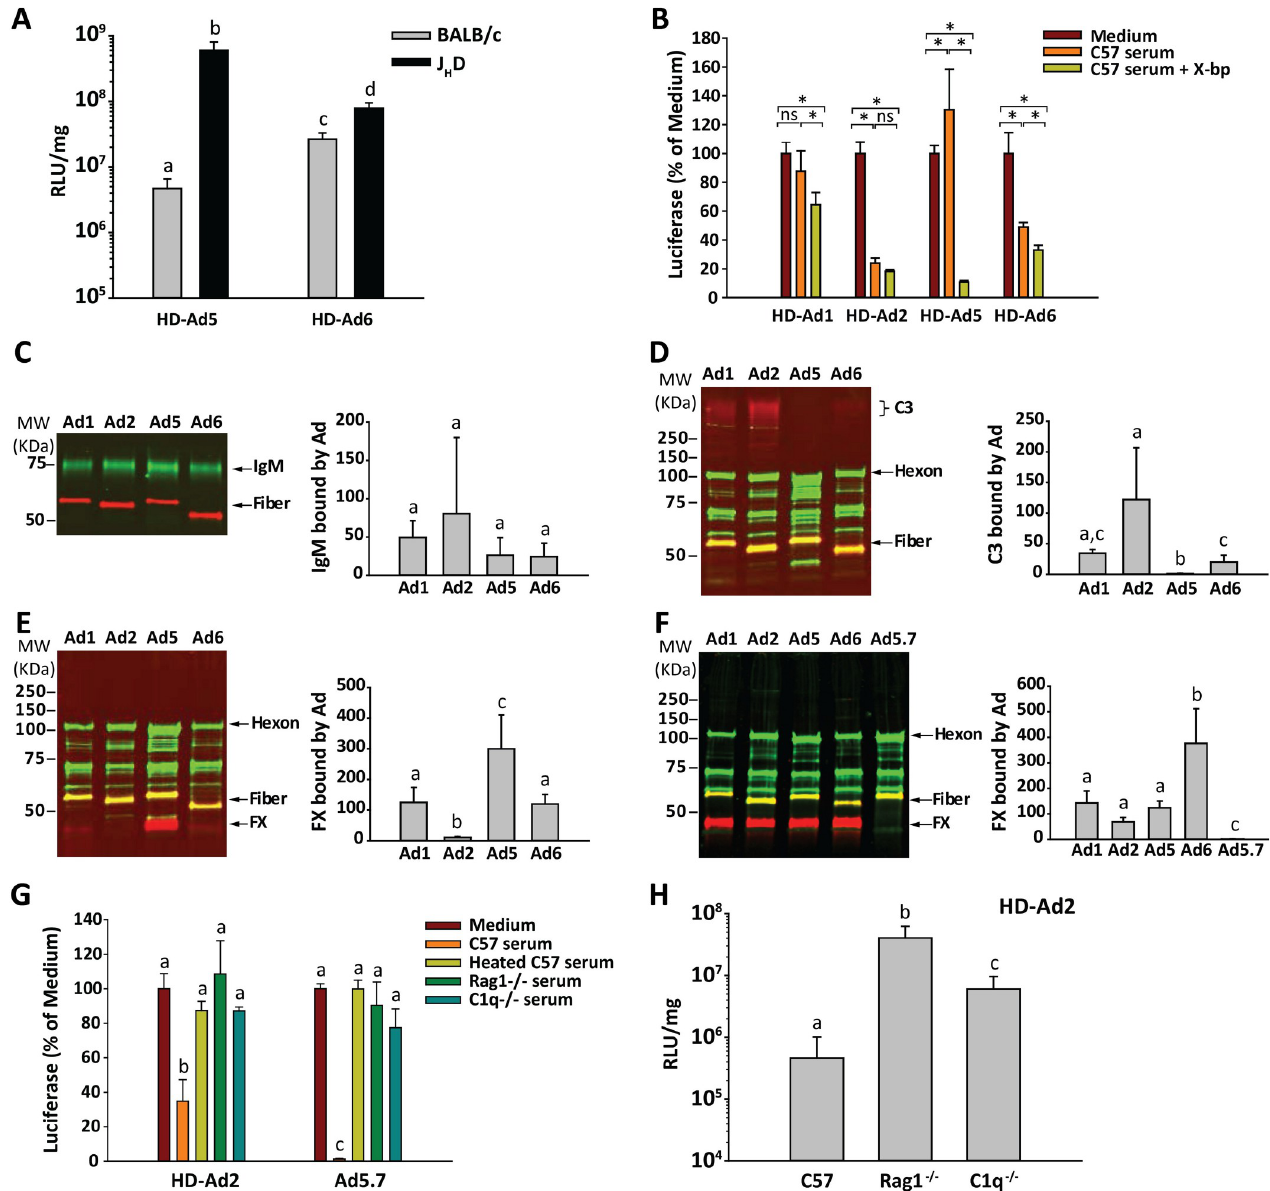
Fig 3. Impact of antibodies and complement on species C Ad vectors. (A) Impact of antibodies on liver luciferase activity after IV injection of HD-Ad5 and HD-Ad6 vectors. Liver luciferase activity was compared in BALB/c mice and antibody-deficient J H D mice on the BALB/c background. n = 5 mice per group. (B) Neutralization of HD-Ad vectors by mouse serum. Vectors were mixed with either medium alone or C57BL/6 mouse serum, with or without the FX- binding protein X-bp. Virus-serum mixtures were diluted and added to 293 cells, and luciferase activity was assessed one day later. n = 6 per group. � P � 0.05 (ANOVA and Holm-Sidak post-hoc test). (C, D, E) Binding of mouse serum proteins to Ad virions. Wild-type Ad 1, 2, 5 and 6 were incubated for 30 min at 37˚C with mouse serum, and virions were separated from non-bound serum components by density gradient ultracentrifugation. Virions and their bound proteins were assessed by quantitative western blot for binding of (C) IgM, (D) C3 or (E) FX. One representative western blot is shown, and graphs show the mean and SD of 5 samples per group. (F) Purified mouse FX was mixed with Ad virions, and bound FX was analyzed by western blot. Ad5.7 is a mutant Ad5 vector that is unable to bind FX, used here as a negative control. n = 3 per group. (G) The role of antibodies and complement in neutralization of HD-Ad2 vector by mouse serum. HD-Ad2 or Ad5.7 (non-FX-binding Ad5 vector) was mixed with mouse serum, and the ability of vector to transduce 293 cells was assessed by measuring luciferase activity. In addition to serum from C57BL/6 mice, we used heat-treated (complement-inactivated) serum, serum from antibody-deficient mice ( Rag1 -/- ), and serum from mice lacking the classical complement pathway ( C1q -/- ). n = 3 per group. (H) Liver transduction by HD-Ad2 vector in C57BL/6, Rag1 -/- or C1q -/- mice. n = 4 or 5 mice per group. Statistical comparison was performed by ANOVA and Holm-Sidak post-hoc tests, and groups that do not share the same letter are significantly different from each other ( P � 0.05).